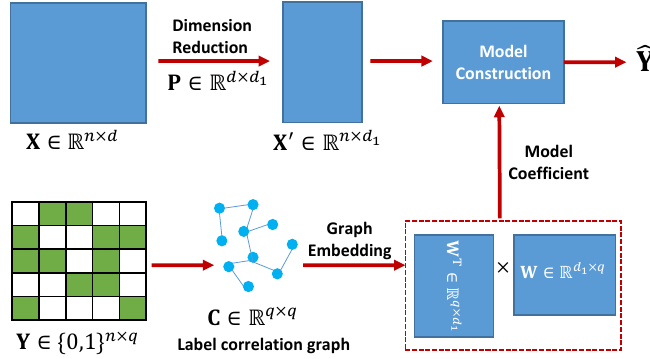
Figure 1. The learning framework of